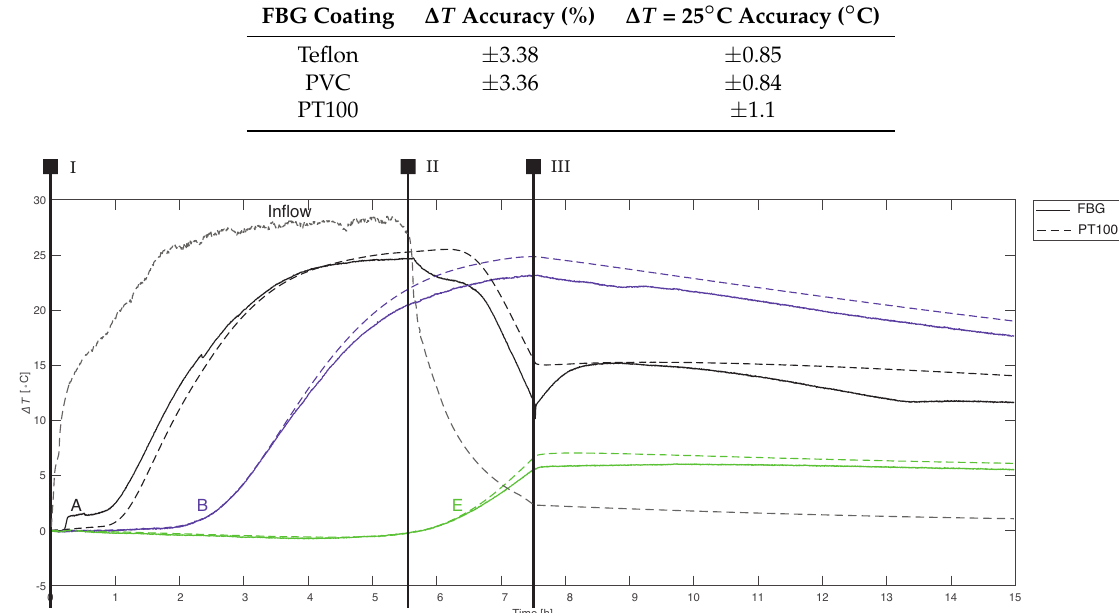
Table 2. A comparison of the temperature accuracy of the FBG and PT100 sensors used in the heat-tracing experiment.